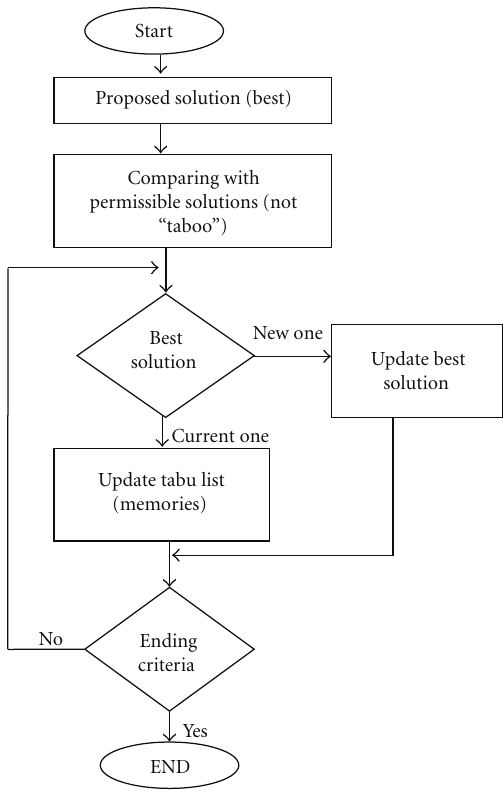
Figure 3: Tabu search